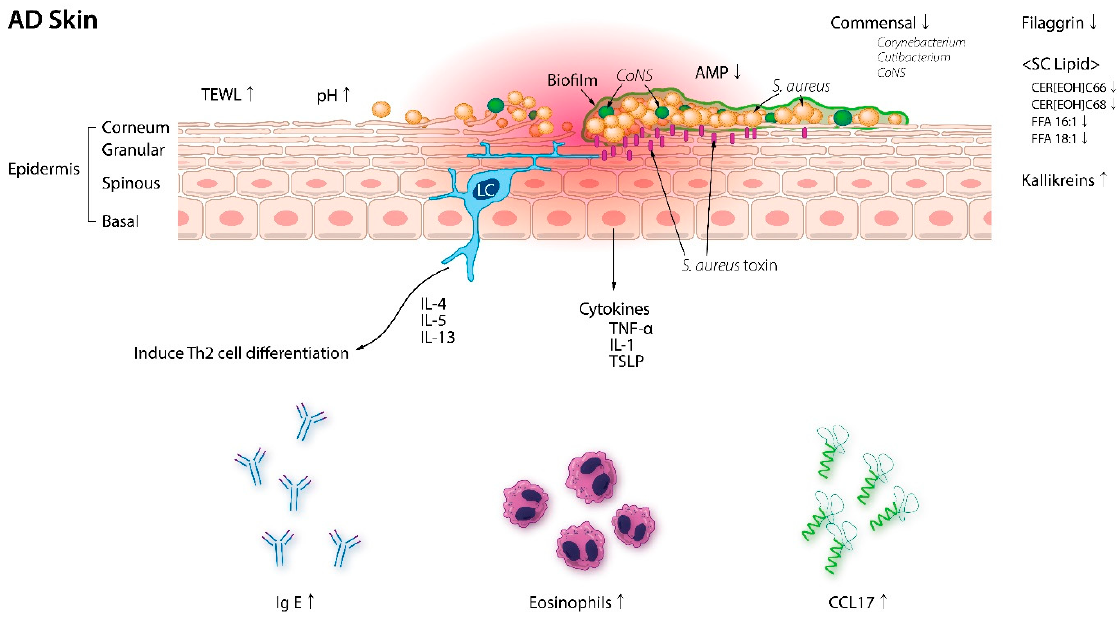
Figure 1. Epidermal barrier disruption in AD skin. Trans-epidermal water loss (TEWL), pH, serum IgE, serum thymus and activated cytokine (TARC/CCL17), and eosinophils are significantly elevated in AD patients. Filaggrin and stratum corneum (SC) lipid composition, and serine protease (Kallikreins) are also altered in AD, allowing S. aureus colonization. With the decrease in coagulase-negative Staphylococci (CoNS) and its antimicrobial peptides (AMP), S. aureus proliferates and also forms biofilms. AD: Atopic dermatitis; CER: Ceramide; FFA: Free fatty acid; IL: Interleukin; S. aureus : Staphylococcus aureus ; TNF: Tumor necrosis factor; TSLP: Thymic stromal